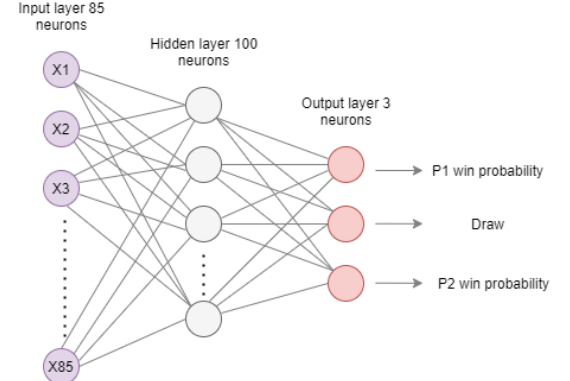
Figure 6. Artificial neural network